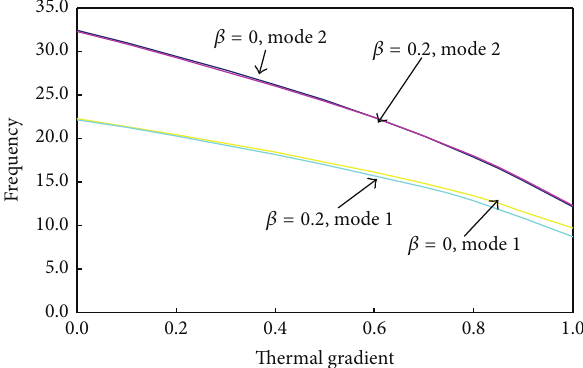
Figure 6: Value of frequency parameter for orthotropic trapezoidal plates for different values of thermal gradient and fixed values for 𝑎/𝑏 = 1.0 , 𝑐/𝑏 = 0.75 .